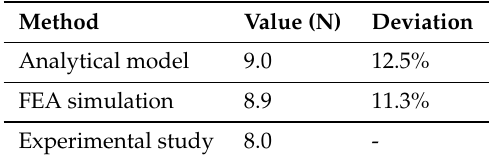
Table 4. Comparison of the constant-force values for